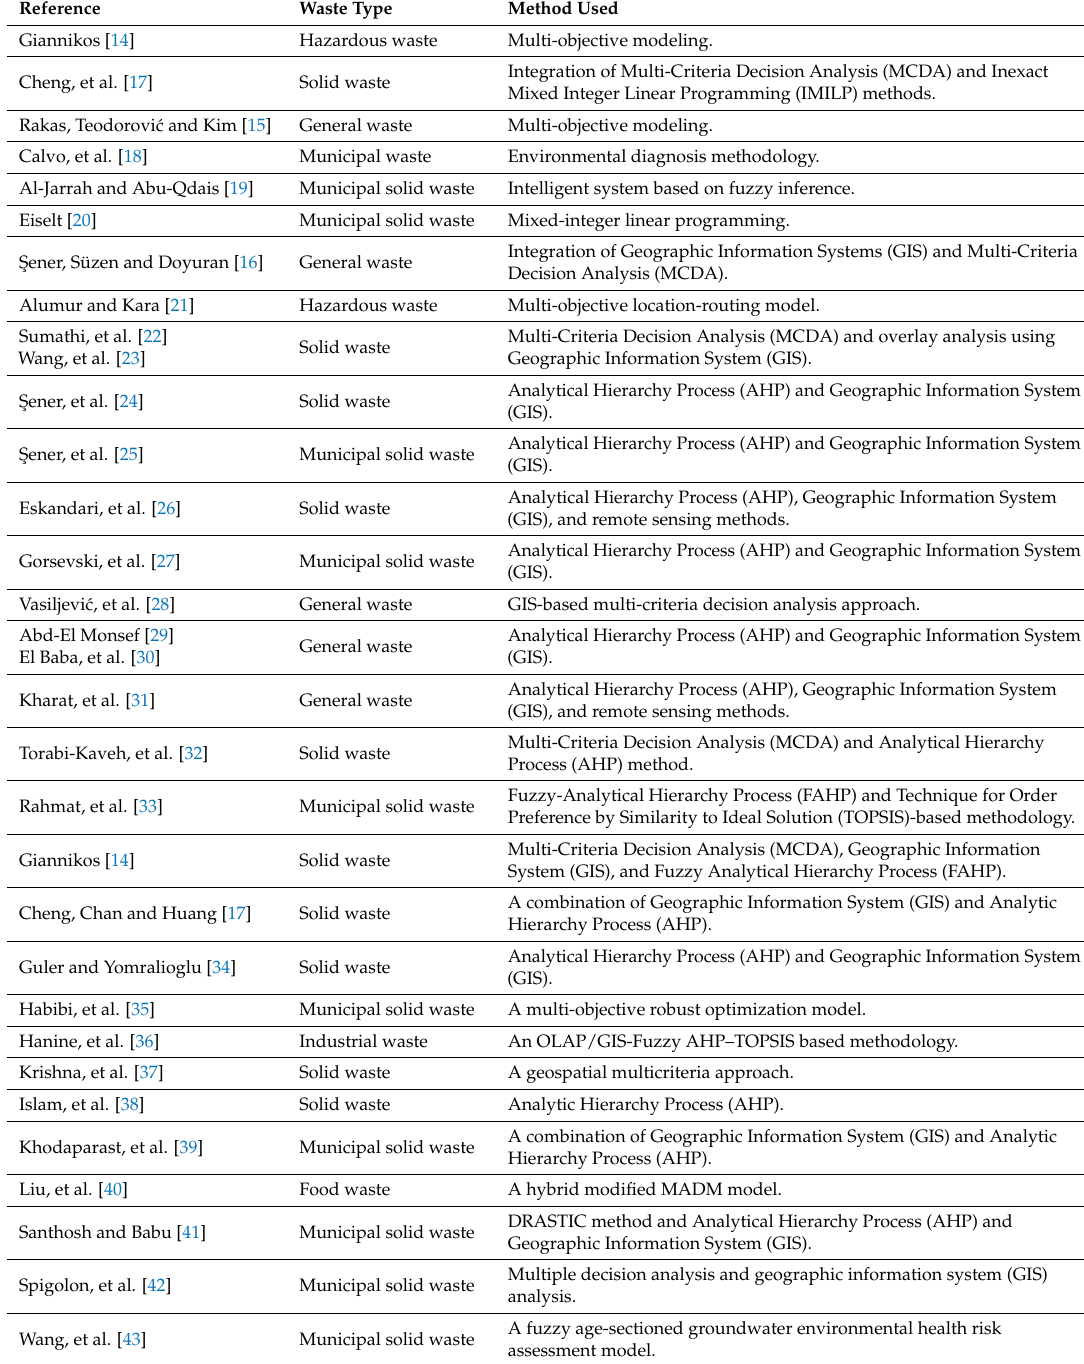
Table 1. Summary of existing